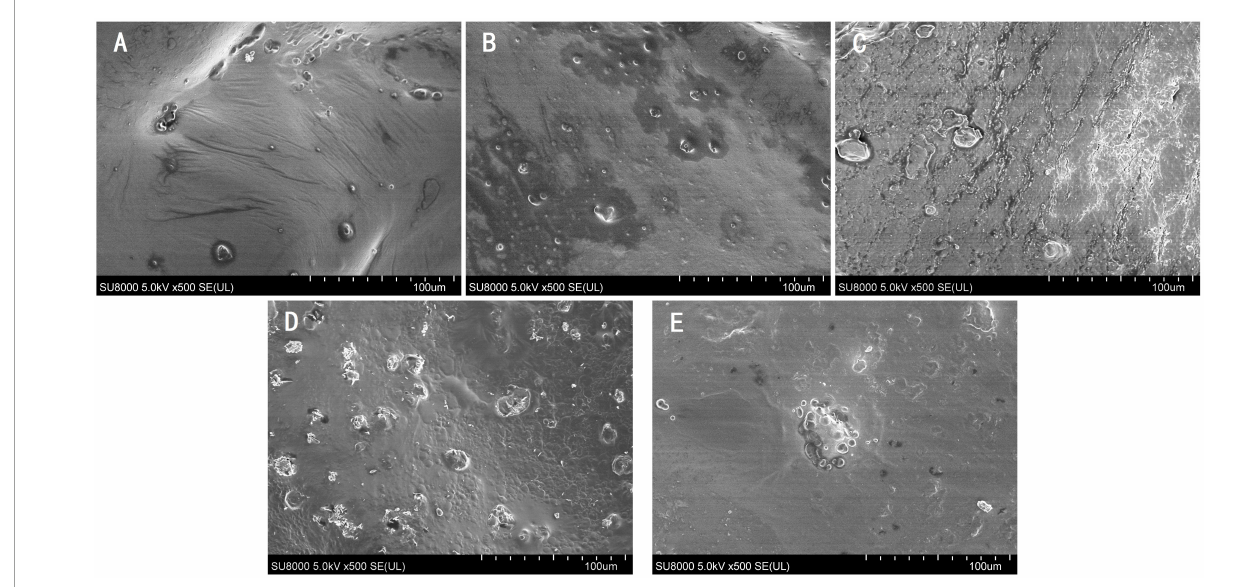
FIGURE7 Microstructure observation (500 × magnifications) of sea buckthorn berries under different drying methods. (A) Hot air drying (HAD); (B) infrared drying (IRD); (C) infrared-assisted hot air-drying (IR-HAD); (D) pulsed vacuum drying (PVD); (E) vacuum freeze drying